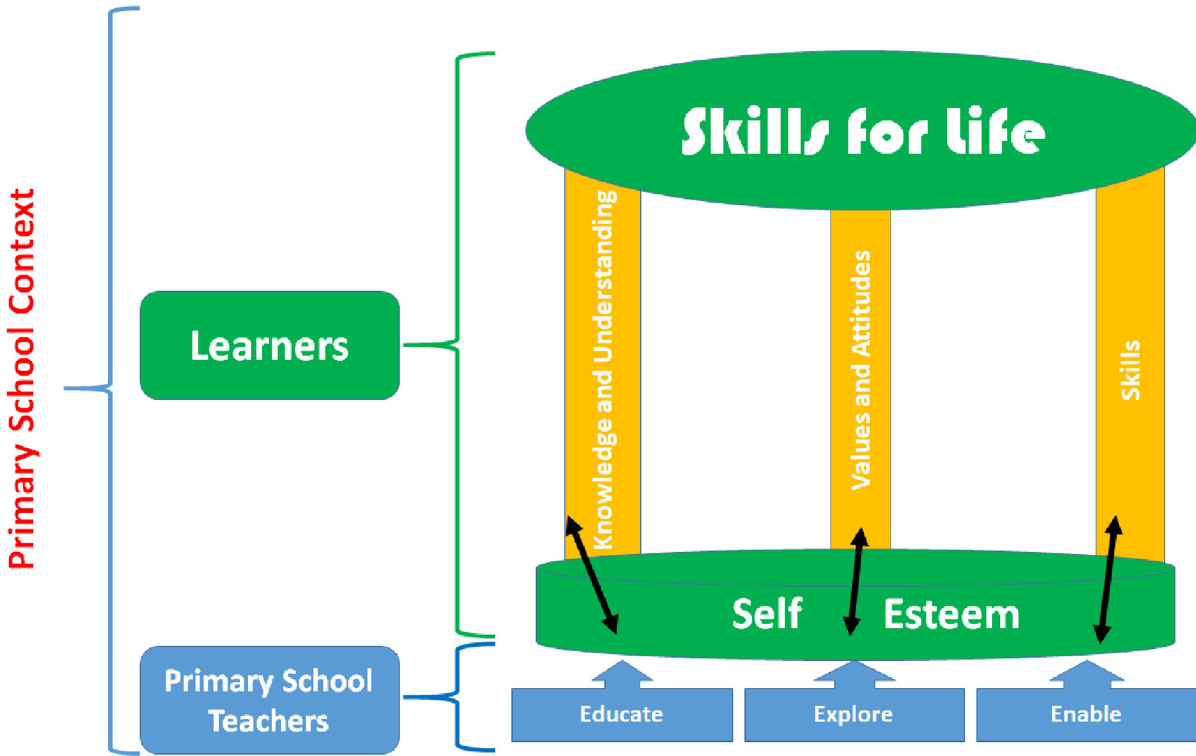
Fig 1. The life skill approach model adapted from the SNR Consultancy & Training